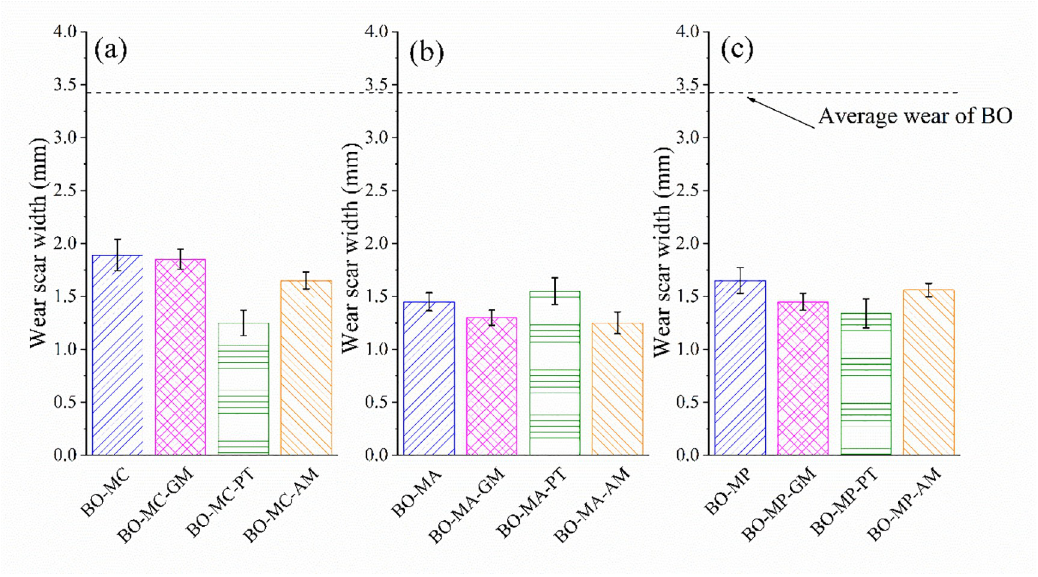
Fig 9. Wear scar width of block lubricated with different test oil formulas at